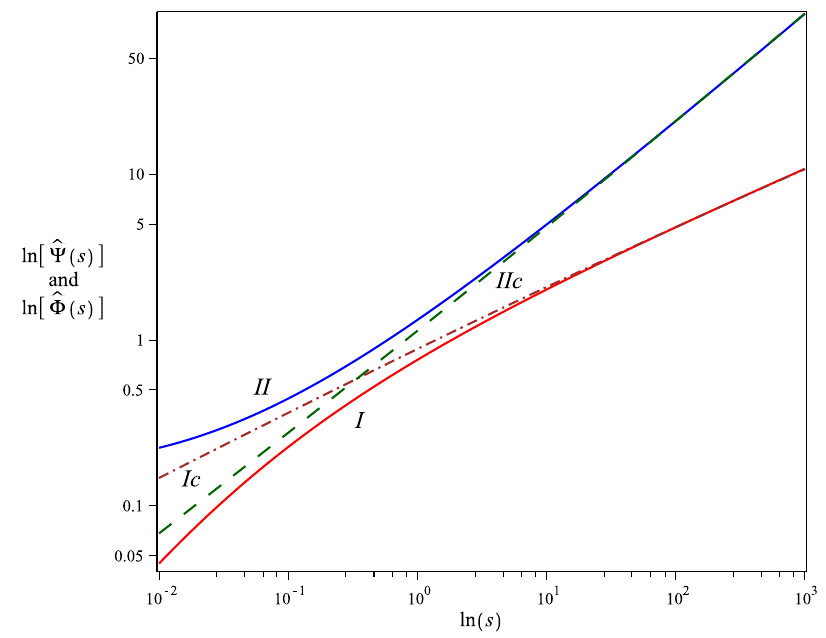
Figure 3. Plot presents the comparison between (cid:98) Ψ KWW ( s ) (red solid curve no. I ) and (cid:98) Ψ JWS ( s ) (brown dot-dashed curve no. Ic ), as well as between (cid:98) Φ KWW ( s ) (blue solid curve no. II ) and (cid:98) Φ JWS ( s ) (green dashed curve no. IIc ). (cid:98) Ψ KWW ( s ) and (cid:98) Φ KWW ( s ) are calculated with the help of Equation (8) where we use α KWW = 1/3, τ = 1. The characteristic exponents (cid:98) Ψ JWS ( s ) and (cid:98) Φ JWS ( s ) are given by Equations (16) where α JWS = 2/5, β JWS = 5/6, and are, respectively, multiplied and divided by [ Γ ( 1 + 2/5 )] − 1